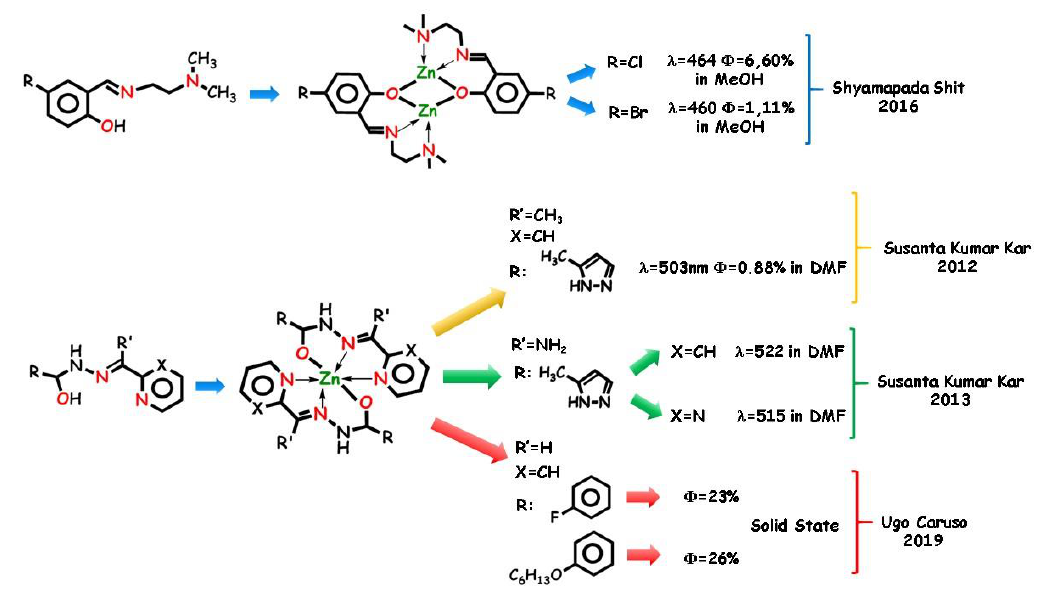
Figure 6. N , N , O pincers containing half- salen moiety and related complexes.